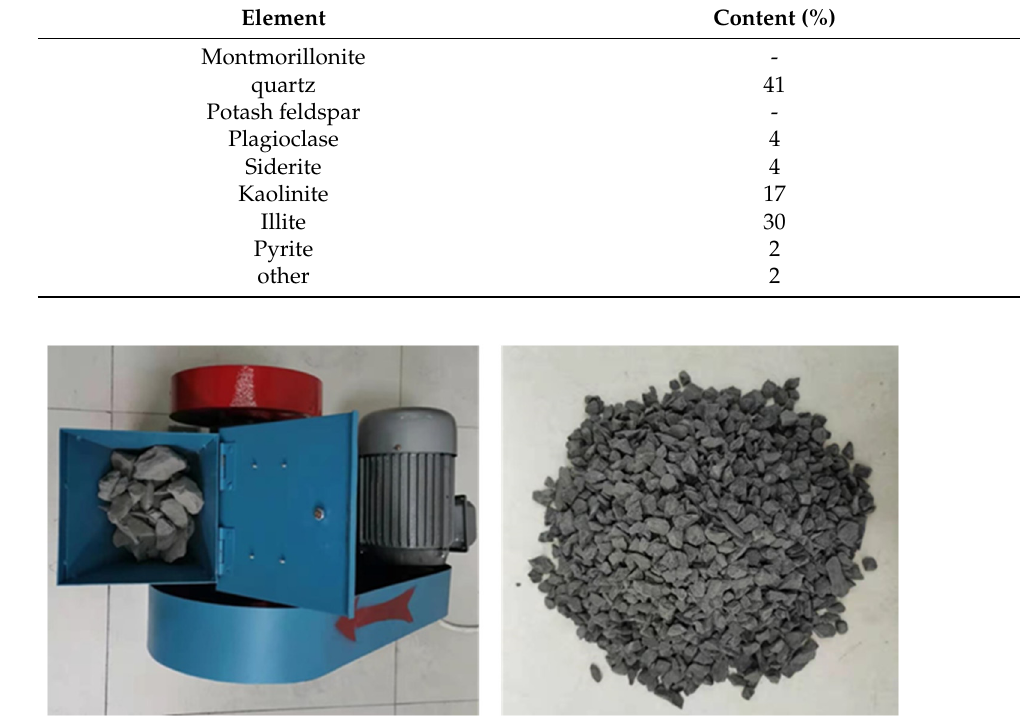
Table 4. Main chemical composition and content of coal gangue /%.